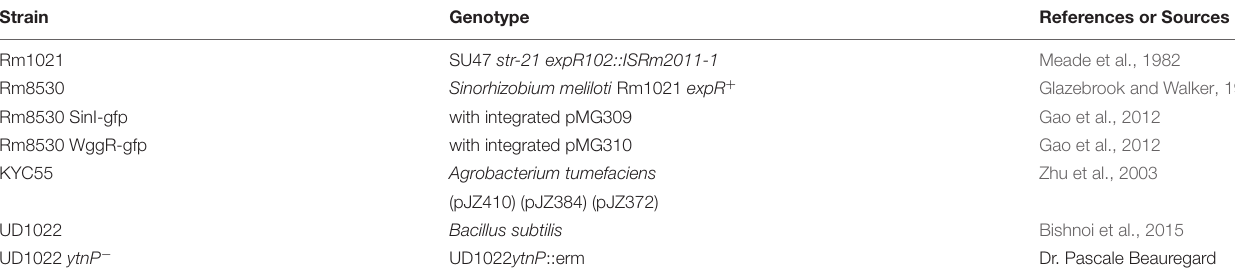
TABLE 1 | Bacterial strains used in this study.